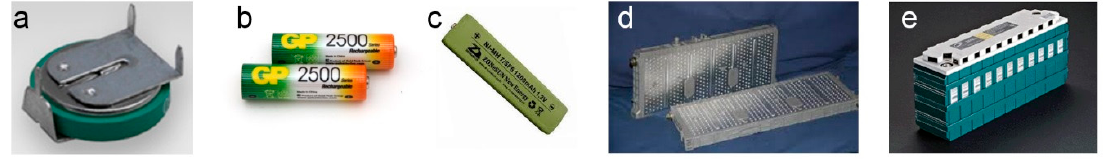
Figure 1. Nickel/metal hydride (Ni/MH) batteries in ( a ) a coin cell, ( b ) a cylindrical cell, ( c ) a stick cell (small prismatic), ( d ) an EV cell (large prismatic), and ( e ) an hybrid electric vehicles (HEV) cell (large prismatic).